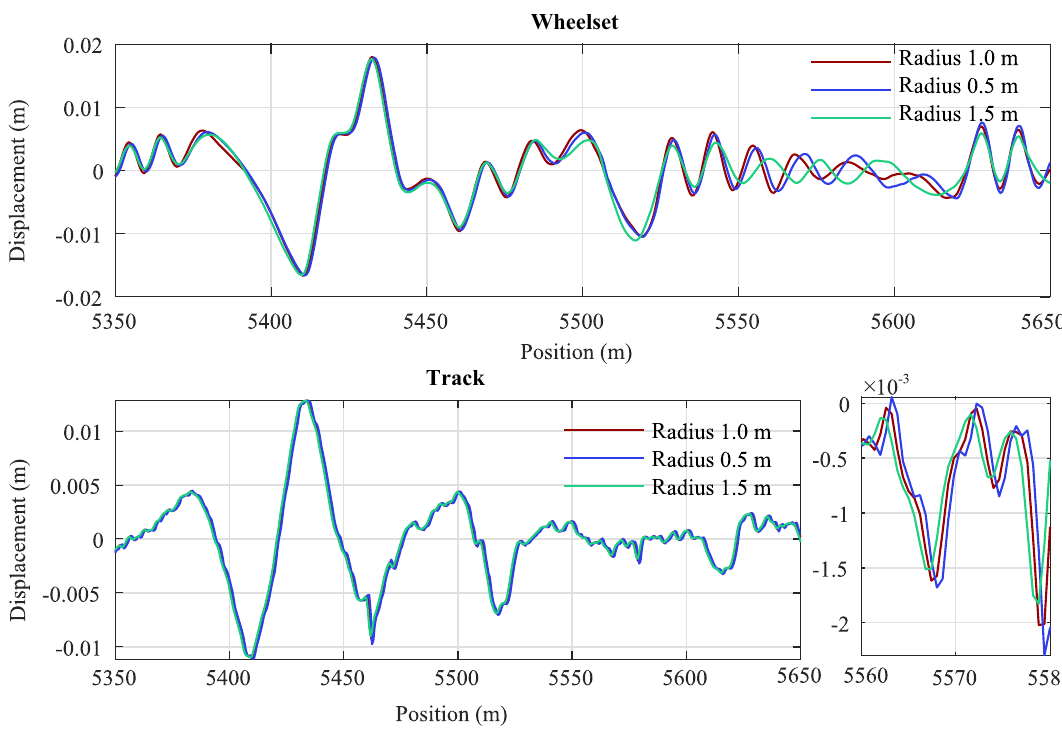
Fig. 5 Simulations with different kernel radii. The upper figure shows the displacement of the wheelset, while the lower figure shows the track displacement. The figure in the lower right corner shows a zoomed-in segment of the track data